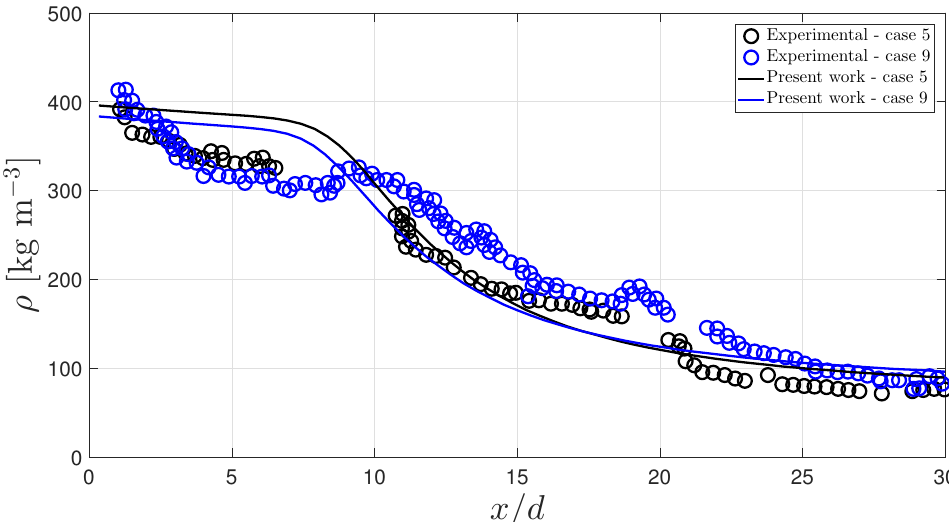
Figure 11. Axial density distribution comparison for cases 5 and 9.